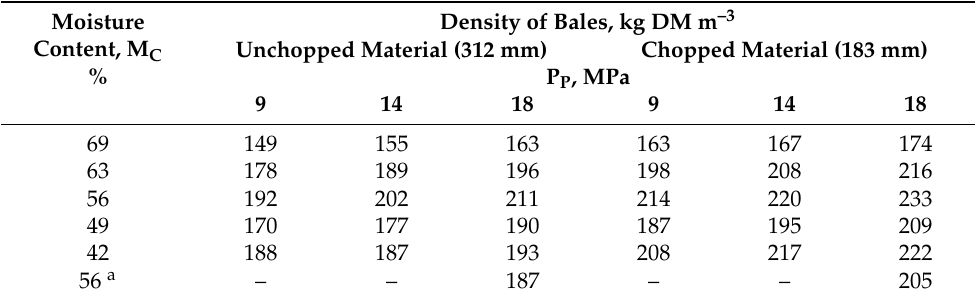
Table 3. Average values of compaction in kg dry matter (DM) m –3 in bales for chopped and un- chopped plant material at pressing pressures (P P ) of 9, 14, and 18 MPa.